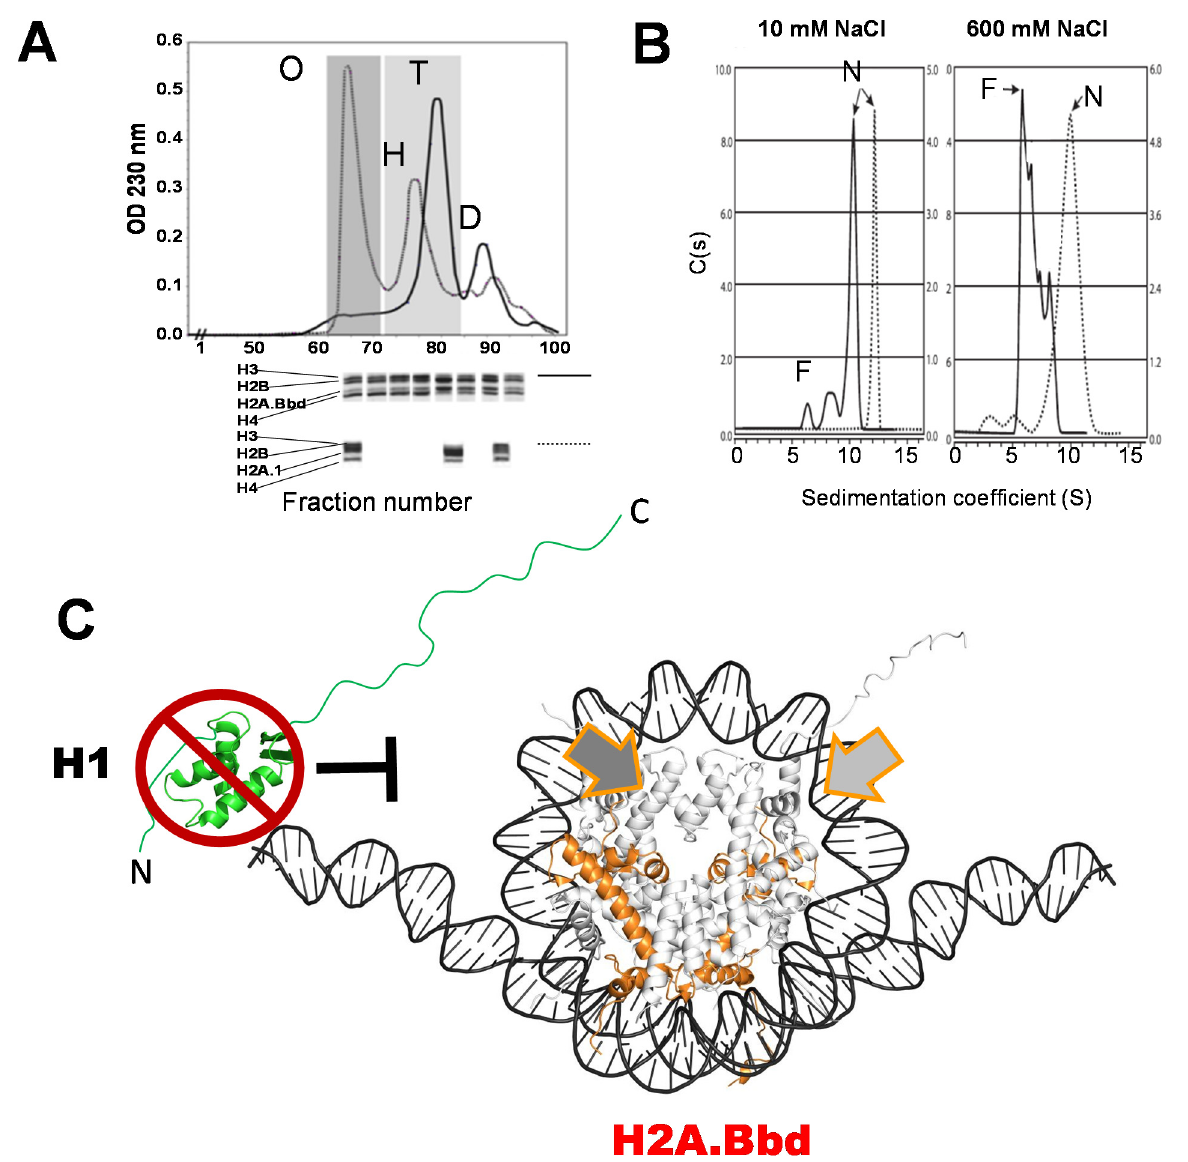
Figure 3. ( A ) Stability of the histone core octamer consisting of canonical H2A (solid line) or histone H2A.Bbd (dotted line) in the presence of 2M NaCl, as determined by gel filtration chromatography on a Sephacryl S-300 HR resin. O: octamer ((H3-H4) 2 .2(H2A-H2B)), H: hexamer ((H3-H4) 2 . (H2A-H2B)), T: tetramer ((H3-H4) 2 .), D: dimer ((H2A-H2B)/ (H2A.Bbd-H2B)). The histones eluting with the different elution peaks are visualized in the SDS-PAGE shown underneath; ( B ) Ionic-strength-dependent stability of reconstituted NCPs containing H2A.Bbd (dotted line), in comparison to NCPs consisting of canonical H2A (solid line) as determined by sedimentation velocity analysis in the analytical ultracentrifuge. F: free (dissociated) DNA, N: nucleosomes; ( C ) Model for the H2A.Bbd (orange) structure of the H2A.Bbd-containing NCP, based on the crystallographic image of the nucleosome [78,98] and on the hydrodynamic characteristics [99,101] of the particle. The wide arrows indicate the region corresponding to the C-terminal domain of canonical H2A, which is missing in H2A.Bbd. The inability of histone H1 to bind to the H2A.Bbd-containing nucleosome [102] is